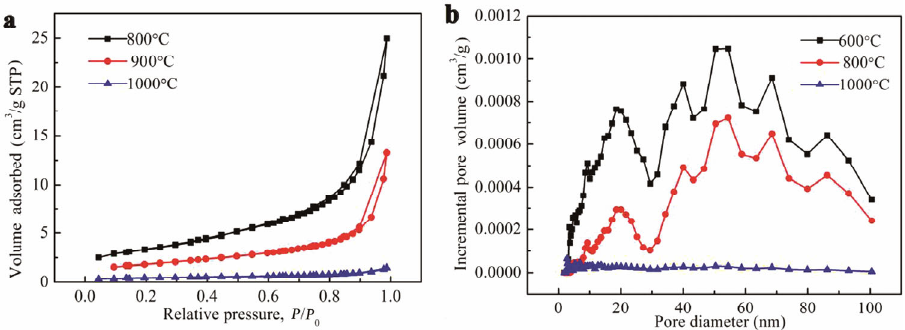
Fig. 8 (a) Nitrogen adsorption–desorption isotherm and (b) corresponding pore size distributions of coal gangue microspheres after calcined at different temperatures. Table 2 Particle size, density, and porous parameters of gangue microspheres